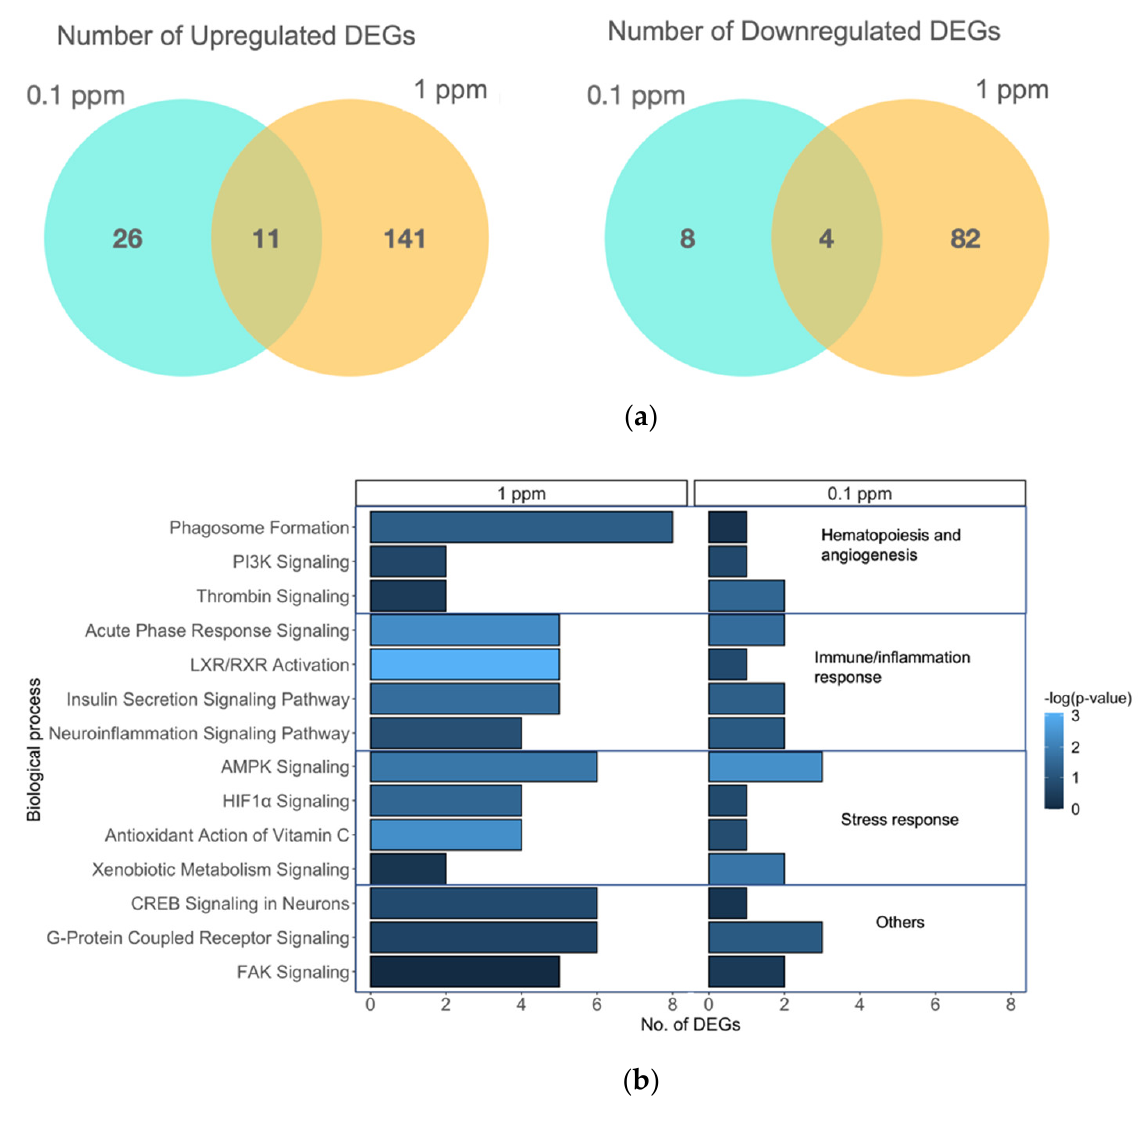
Figure 2. Transcriptomic responses following benzene exposure from 4 h post-fertilization to 5 days post-fertilization (dpf). ( a ) Venn diagram of the number of differentially expressed genes (DEGs) upregulated or downregulated at 0.1, 1 ppm, and both; and ( b ) number of DEGs implicated in top-rank canonical pathways .